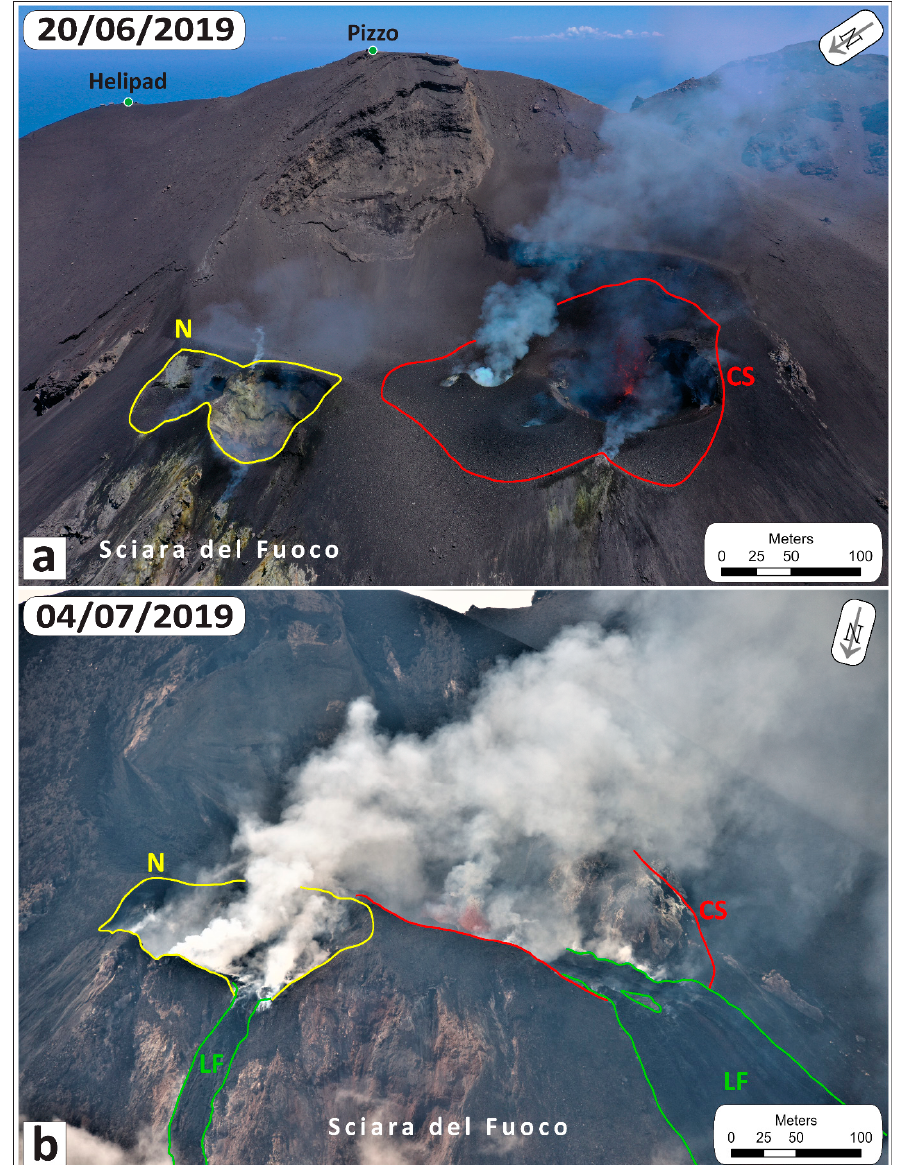
Figure 1. Aerial images of Stromboli’s crater terrace taken before ( a ) and after ( b ) the 3 July 2019 paroxysmal eruption (photos by S. Branca, INGV-OE). N, CS, and LF stand for north crater area, central-south crater area, and lava flows, respectively. Note that the metric scales are approximated and are computed at the center of the scenes.